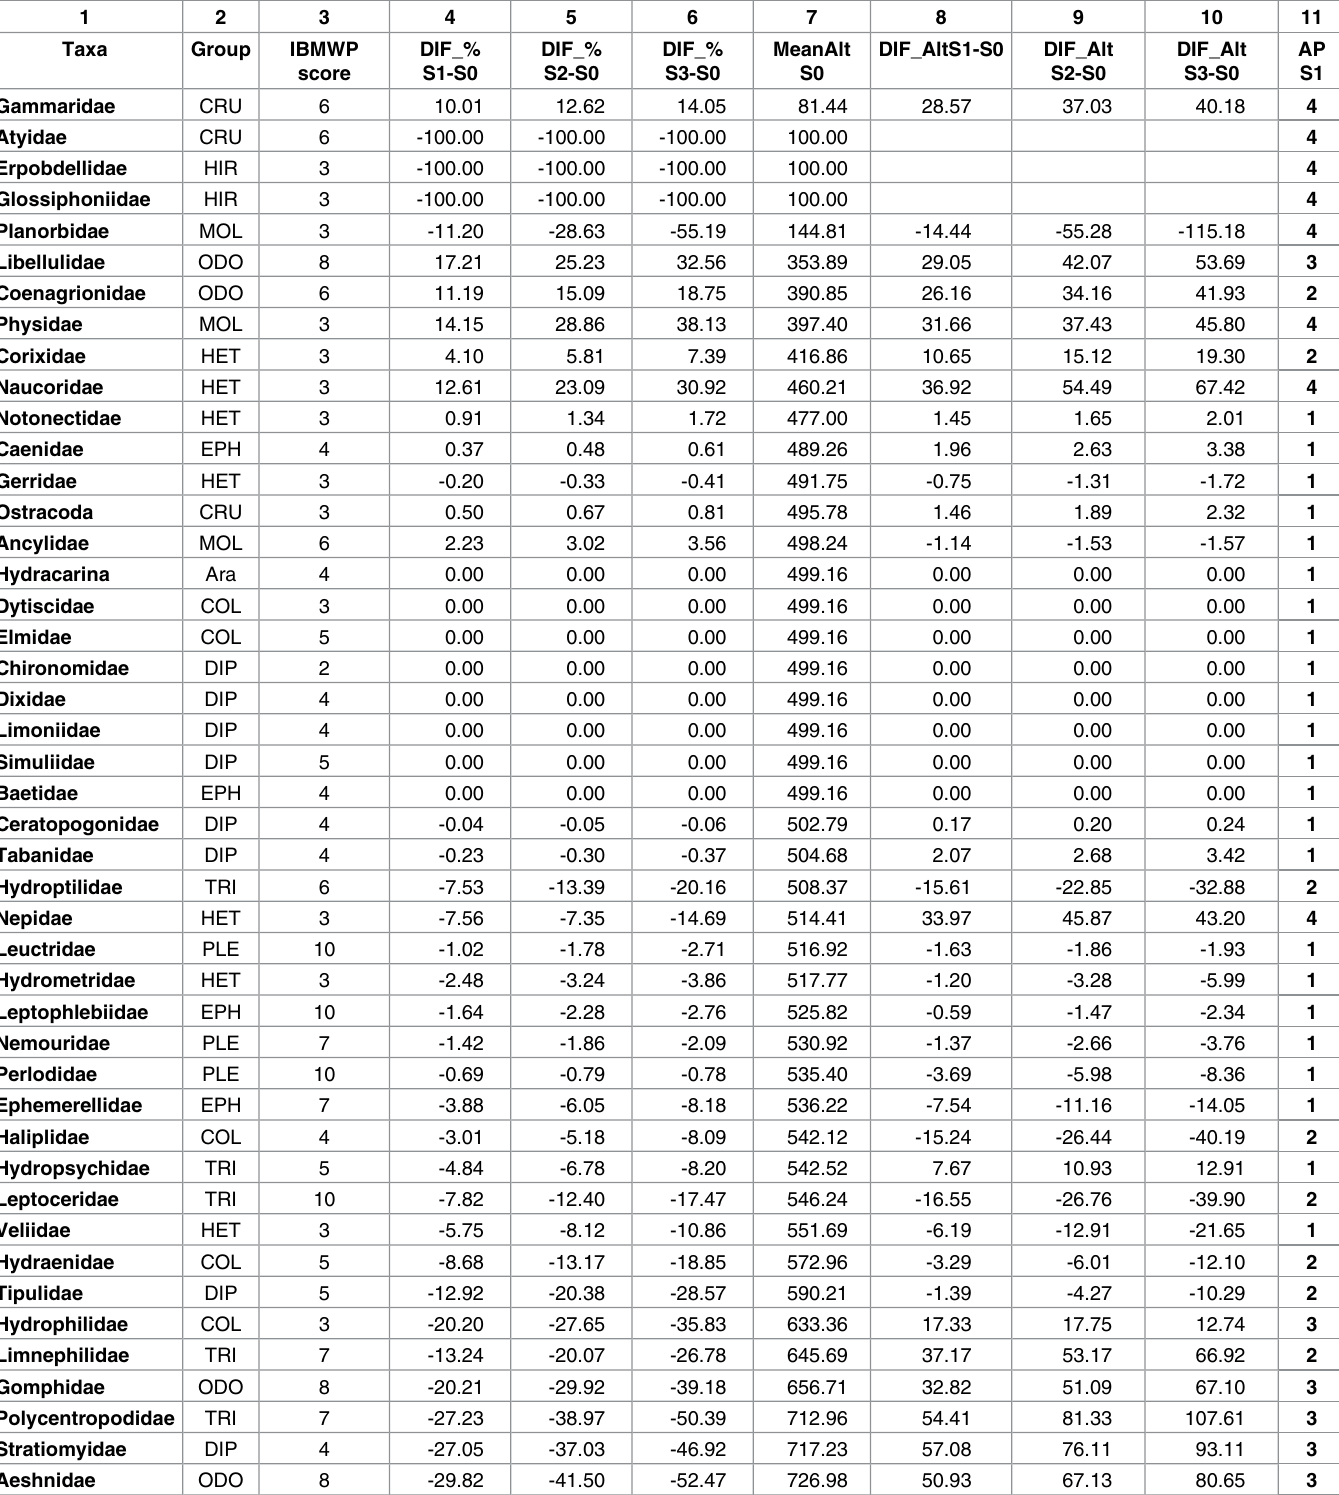
Table 3. Distributional and altitudinal shifts between different modelled scenario and current situation (scenario 0) for each